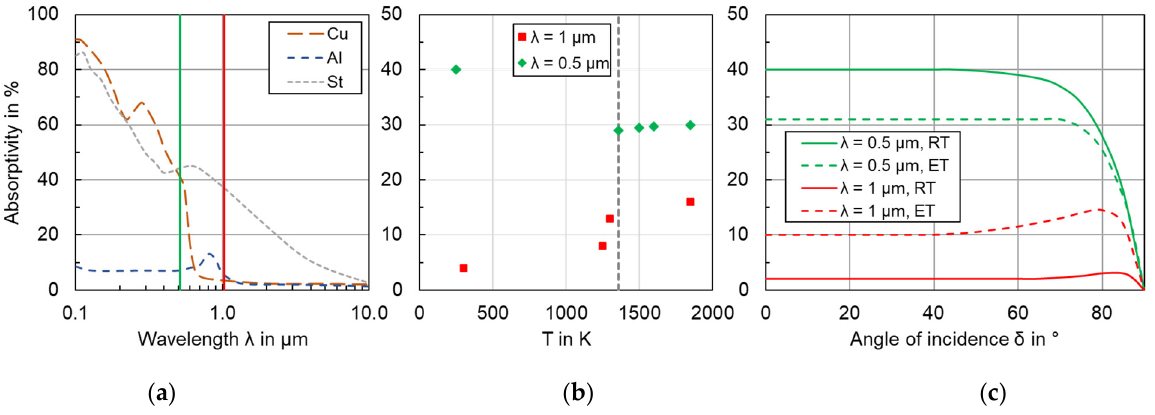
Figure 1. ( a ) Absorption spectra of Cu, Al, and Fe at room temperature; ( b ) temperature dependence of the absorptivity of copper at 0.5 μ m and 1.0 μ m; ( c ) angular dependence of the absorptivity of copper at 0.5 μ m and 1.0 μ mat room temperature (RT) and elevated temperature (ET = 1400 K).